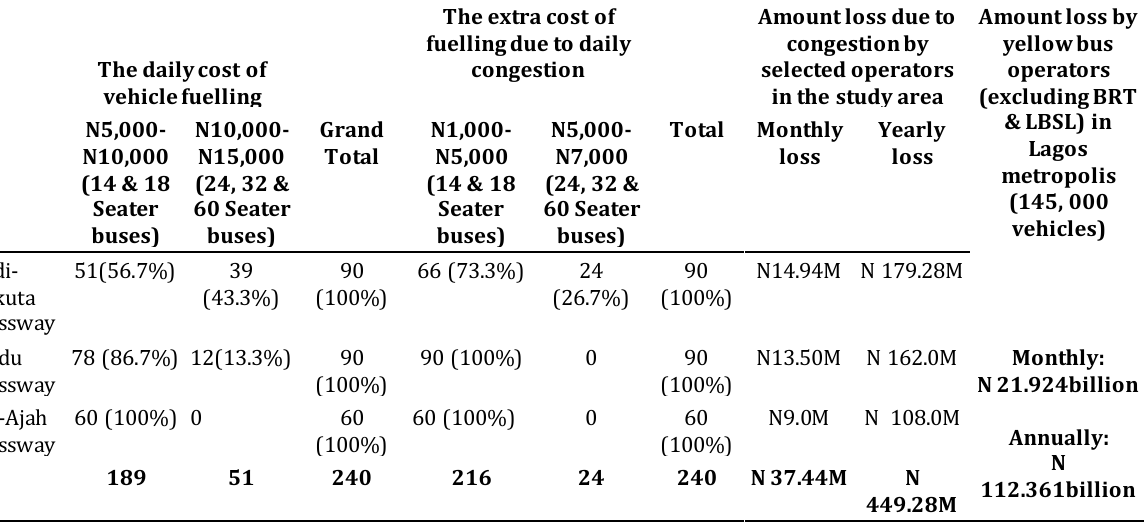
Table 6: Daily bus fueling cost an extra cost of bus fuelling due to congestion